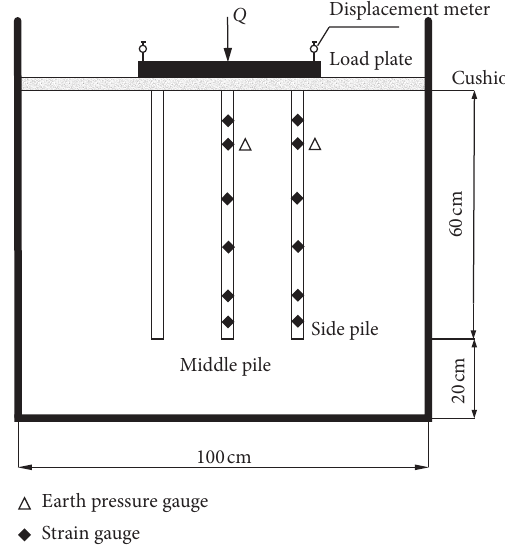
Figure 4: A-A cross section of the group pile composite